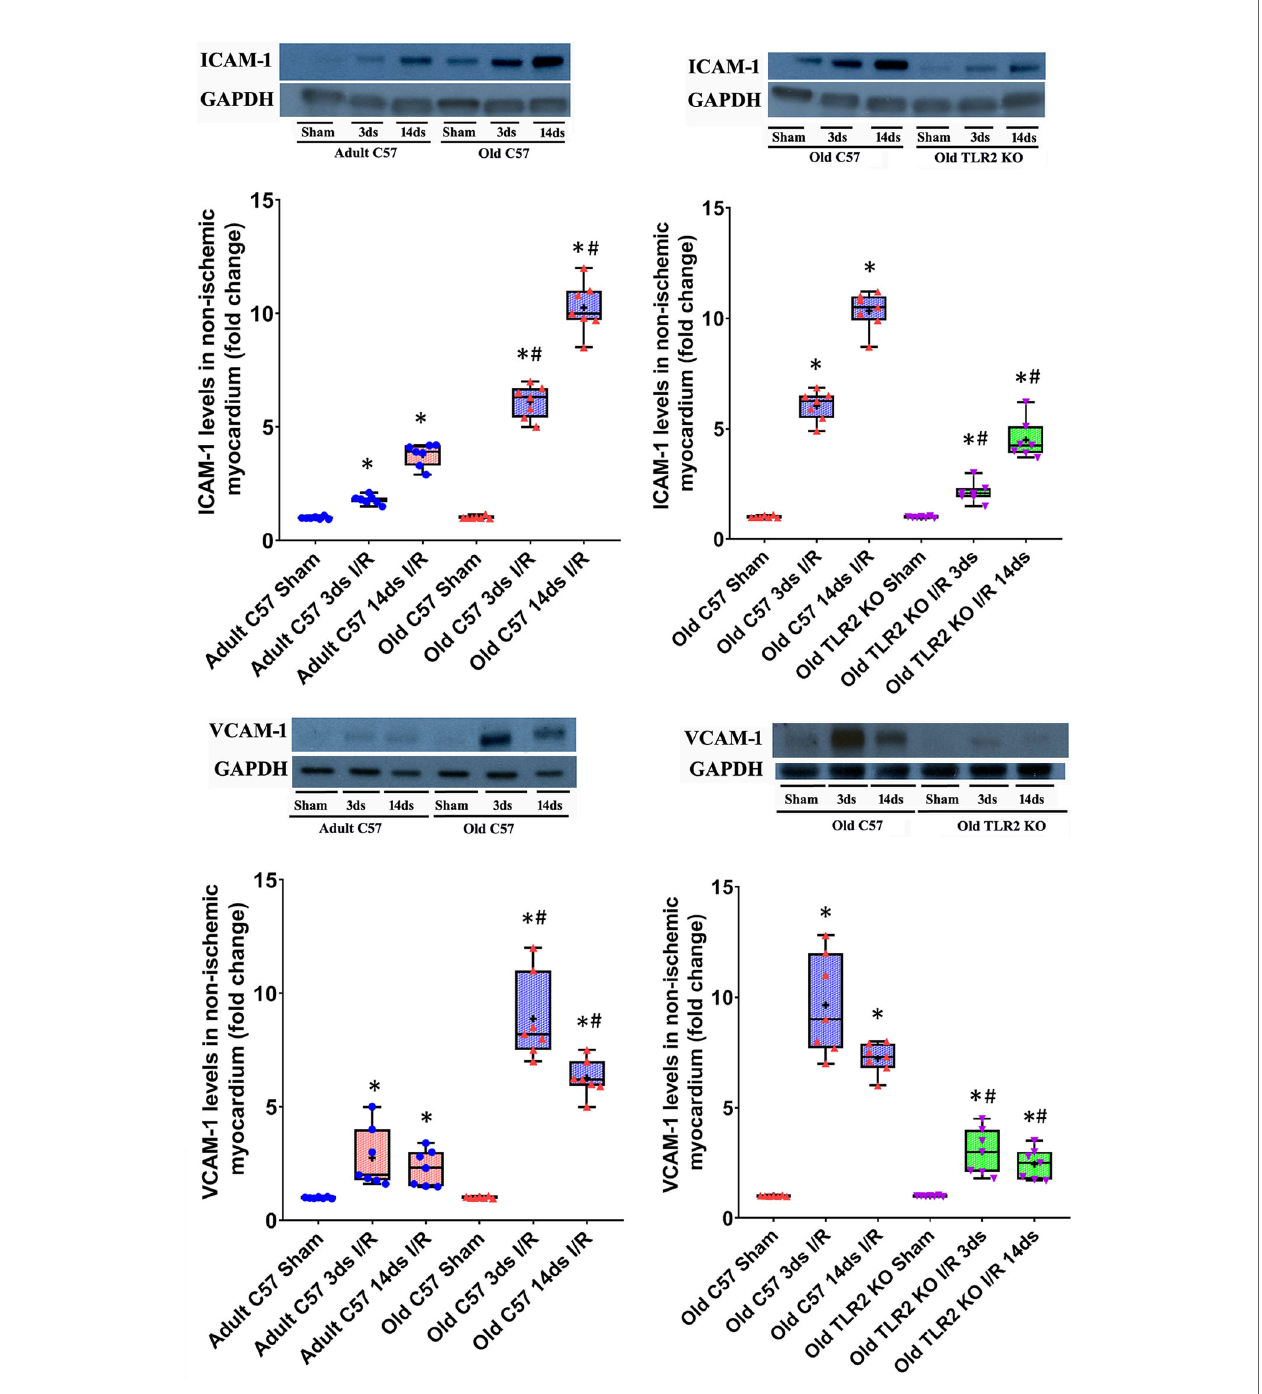
FIGURE 3 | Toll-like receptor (TLR) 2 knockout (KO) suppresses the exaggerated expression of intercellular adhesion molecule (ICAM)-1 and vascular cell adhesion molecule (VCAM)-1 in hearts of old mice. Representative immunoblots and densitometry data show that ICAM-1 and VCAM-1 levels are markedly higher in the non- ischemic myocardium of old C57BL/6 wild-type mice at day 3 and 14 of reperfusion after myocardial ischemia with 30 minutes of left anterior descending artery occlusion in comparison to adult wild type mice. TLR2 KO reduced the levels of these two adhesion molecules in the non-ischemic myocardium of old mice. Data are presented as box-and-whiskers plots where the upper and lower borders of the box represent the upper and lower quartiles; the horizontal line inside the box represents the median; the upper and lower whiskers represent the maximum and minimum values of nonoutliers; and the + sign represents the mean. N = 7 in each group, * P < 0.05 vs. respective sham. # P < 0.05 vs. adult wild type ischemia/reperfusion (I/R) or old wild type